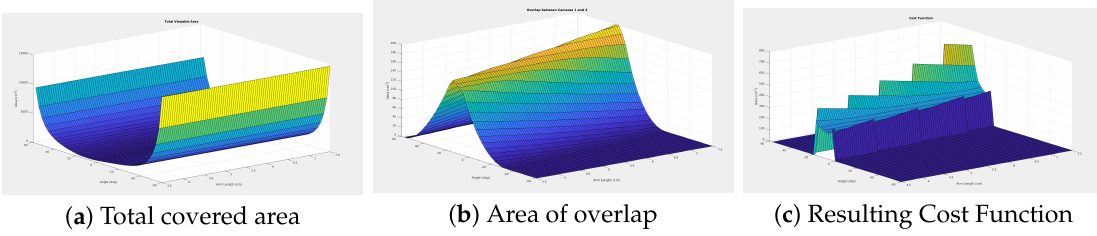
Figure 7. Applying the model to a set of five cameras placed symmetrically on the trocar camera array shows the following: ( a ) the area of the union of the fields of view; ( b ) the area of overlap between Cameras 1 and 2; and ( c ) the cost function that results from thresholding the overlap between each pair of cameras.